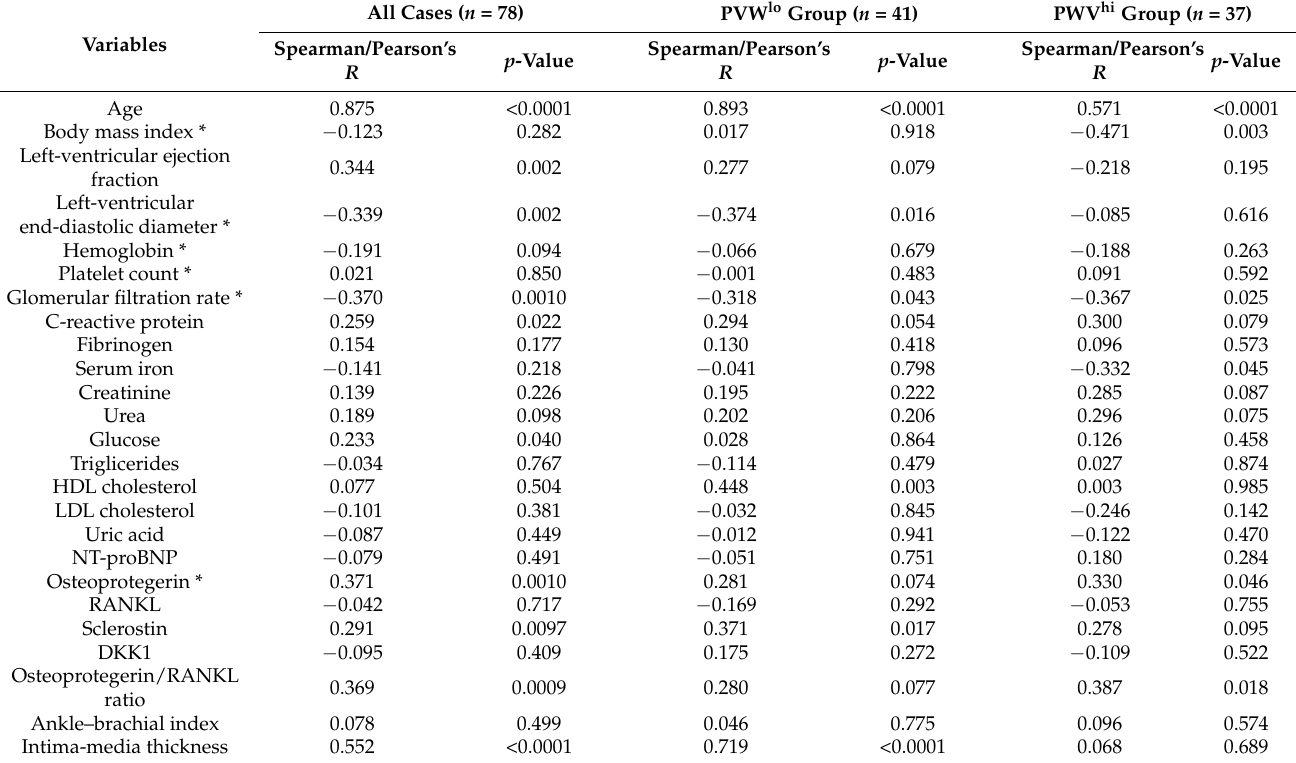
Table 2. Correlations of PWV in the overall, low, and high arterial stiffness